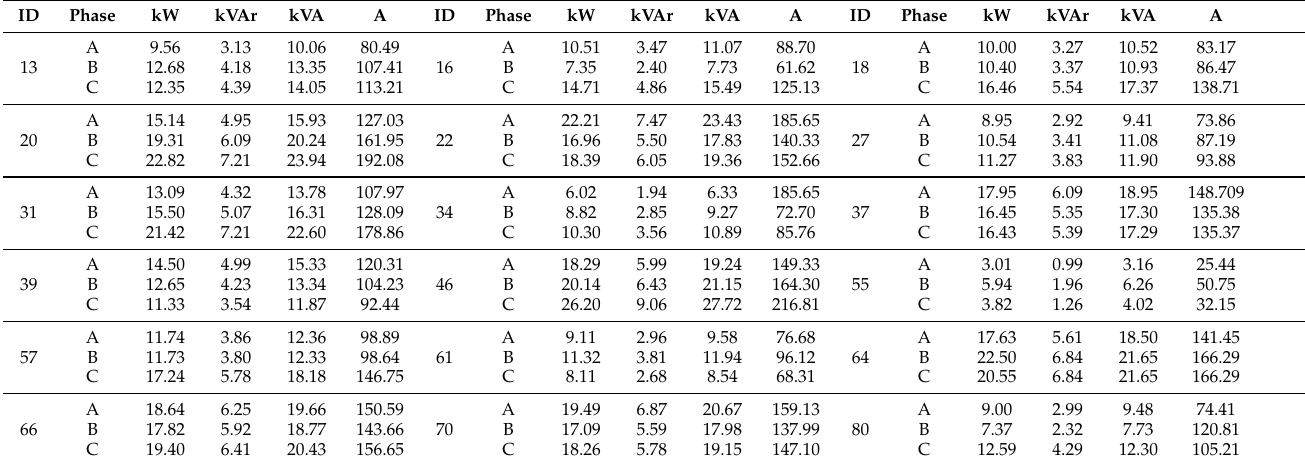
Figure 13. Profile voltages in Cymdist. Table 5. Power flows in the low voltage